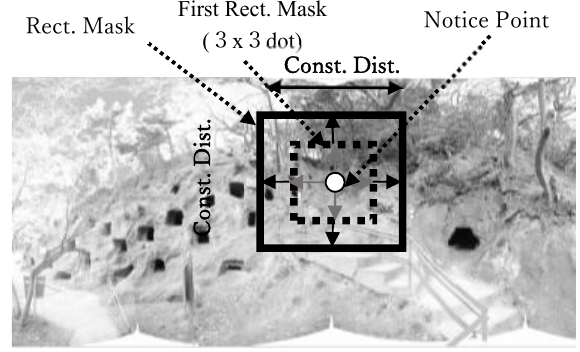
Figure4. Concept of variable mask size